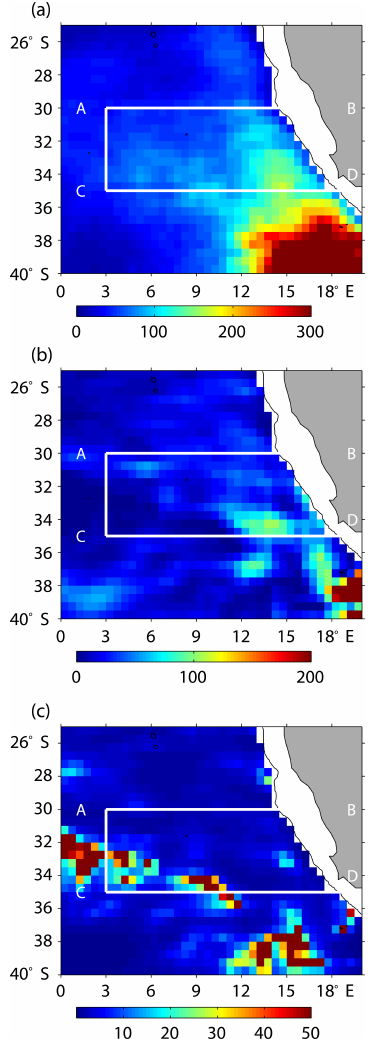
Figure 8. Climatologies of (a) eddy kinetic energy in (cms − 1 ) 2 , (b) mean kinetic energy in (cms − 1 ) 2 , and (c) the ratio of eddy and mean kinetic